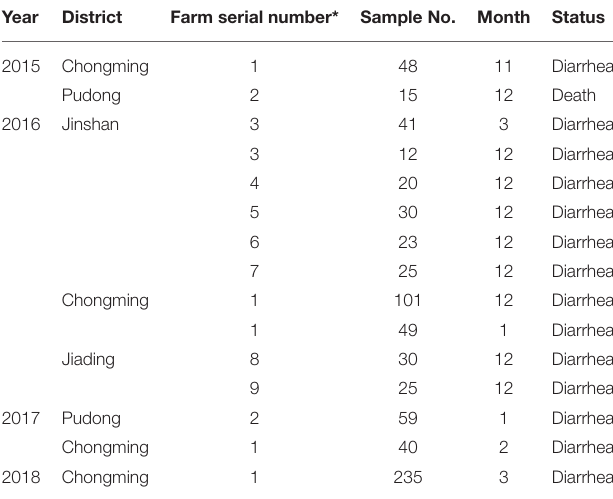
TABLE 1 | The details for porcine stool